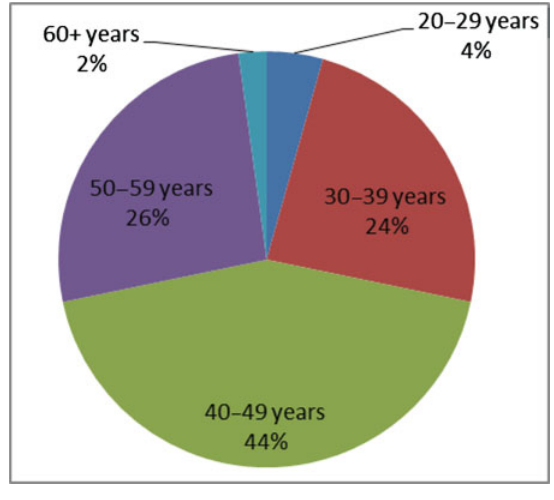
(Colour online) Age of participants when awarded their doctoral qualification.